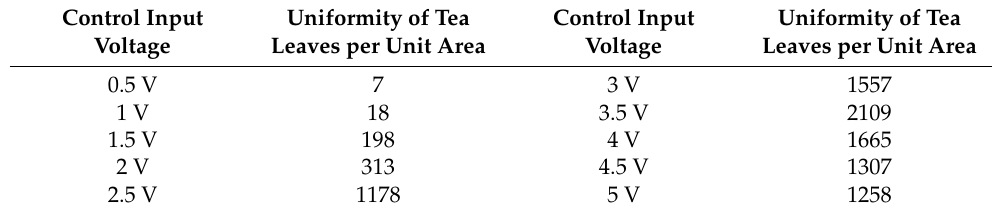
Table 5. Vibratory feeder vibration